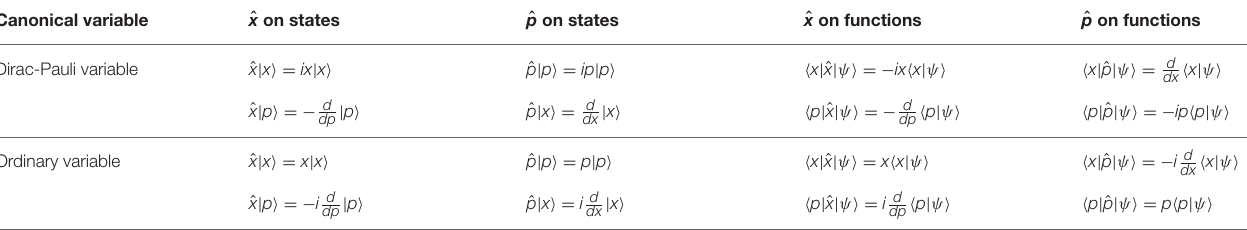
TABLE 2 | Basic properties of a Dirac-Pauli variable (and its conjugate momentum) compared to the ordinary case. Canonical variable ˆ x on states ˆ p on states ˆ x on functions ˆ p on functions Dirac-Pauli